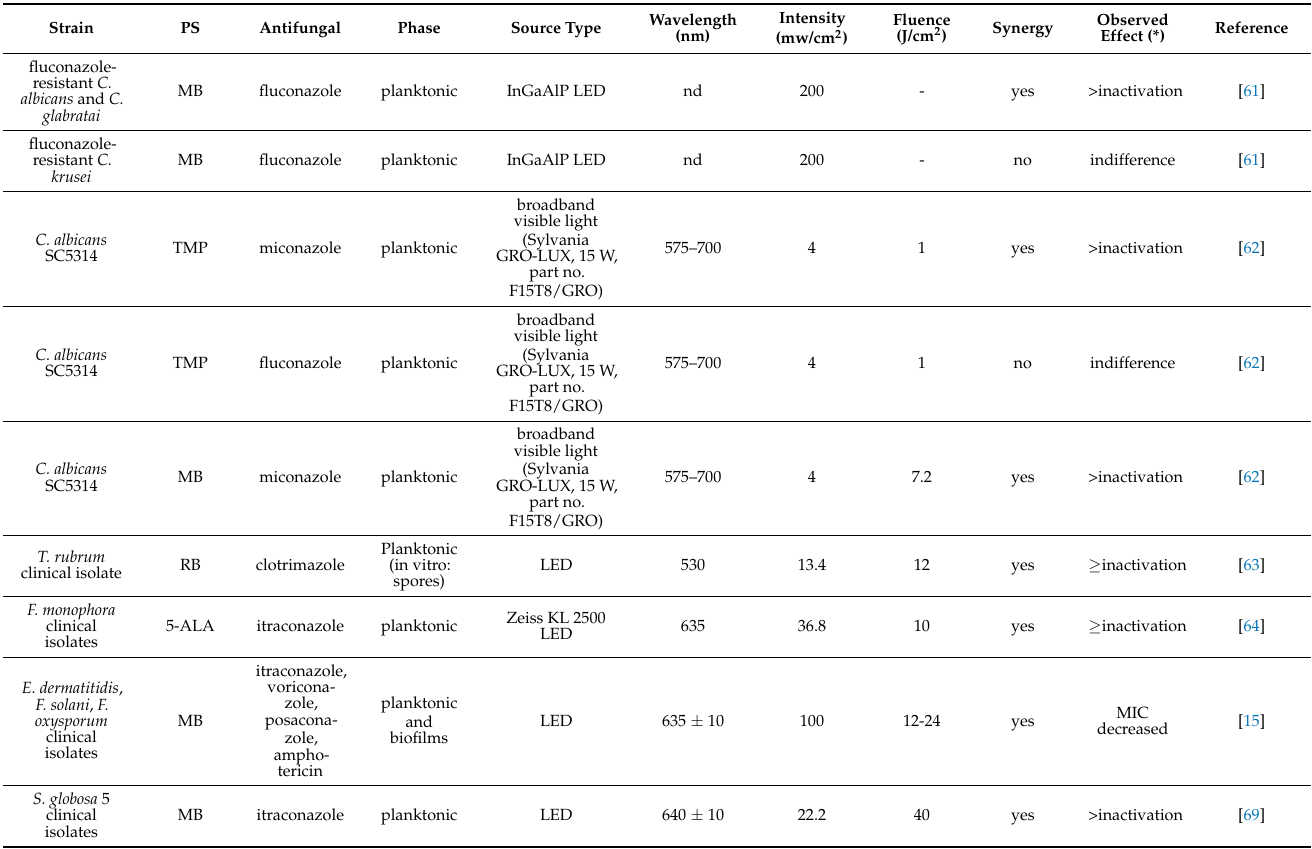
Table 6. Studies on combination of in vitro aPDT plus other treatment against fungus that cause SSTIs comparing the methodology and the